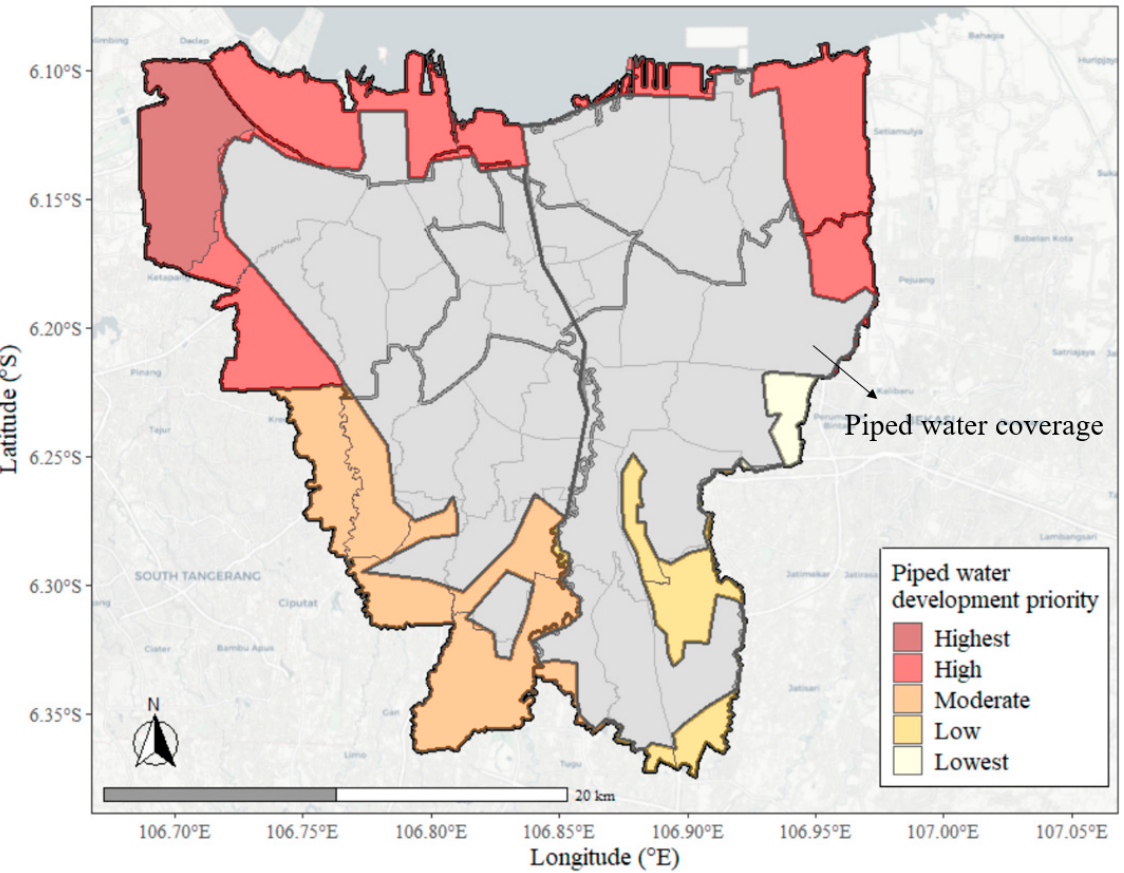
Figure 11. Priority areas for piped water development.